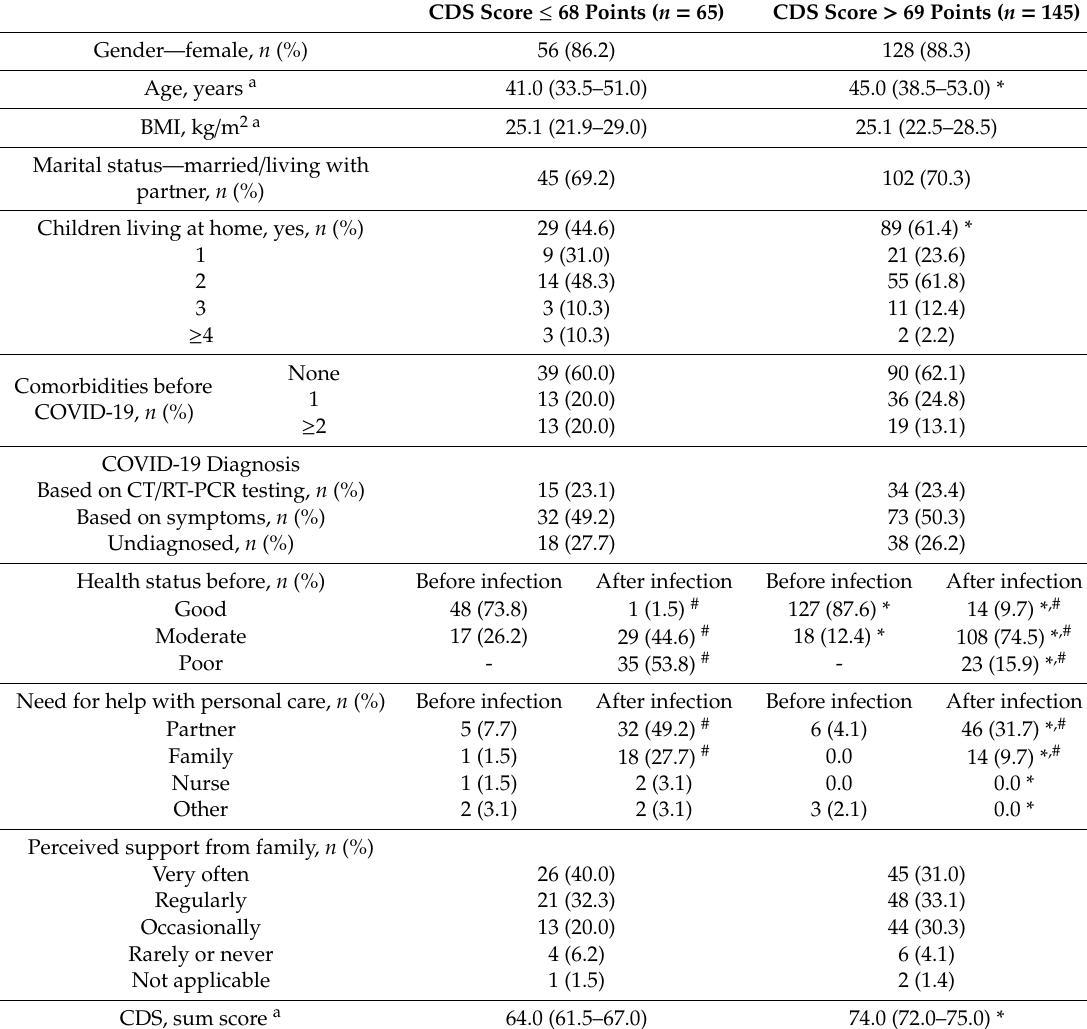
Table 2. Patient characteristics stratified for level of care